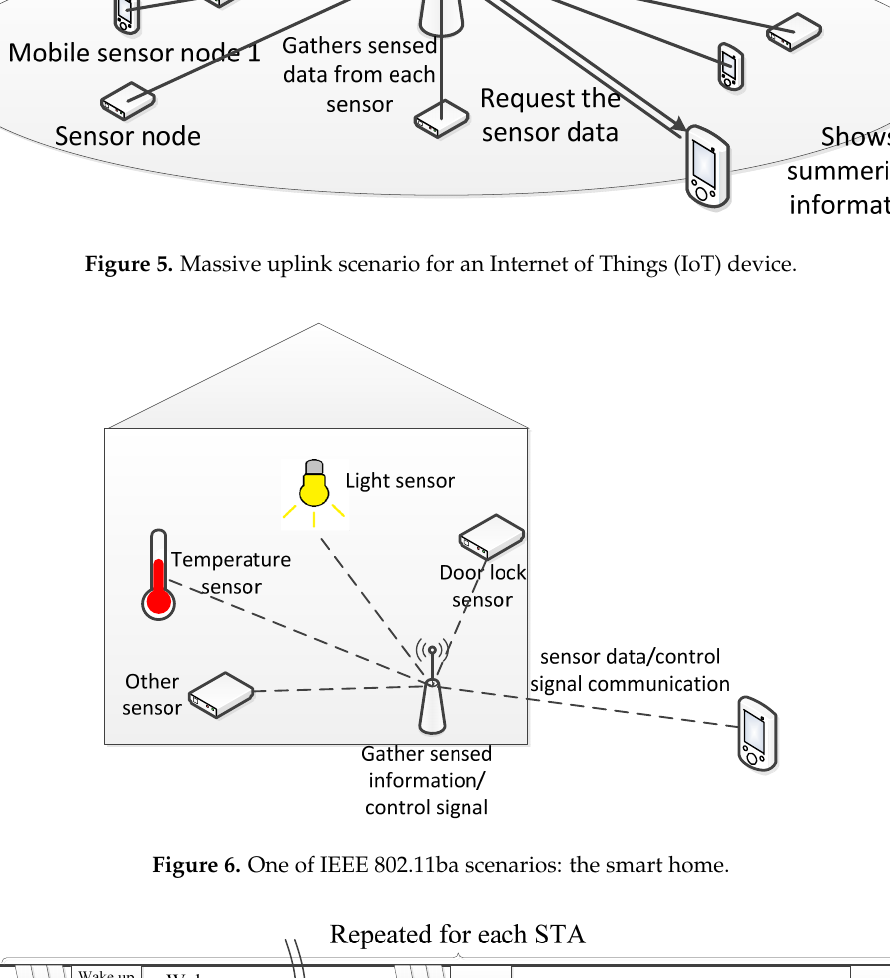
Figure 6. One of IEEE 802.11ba scenarios: the smart home.